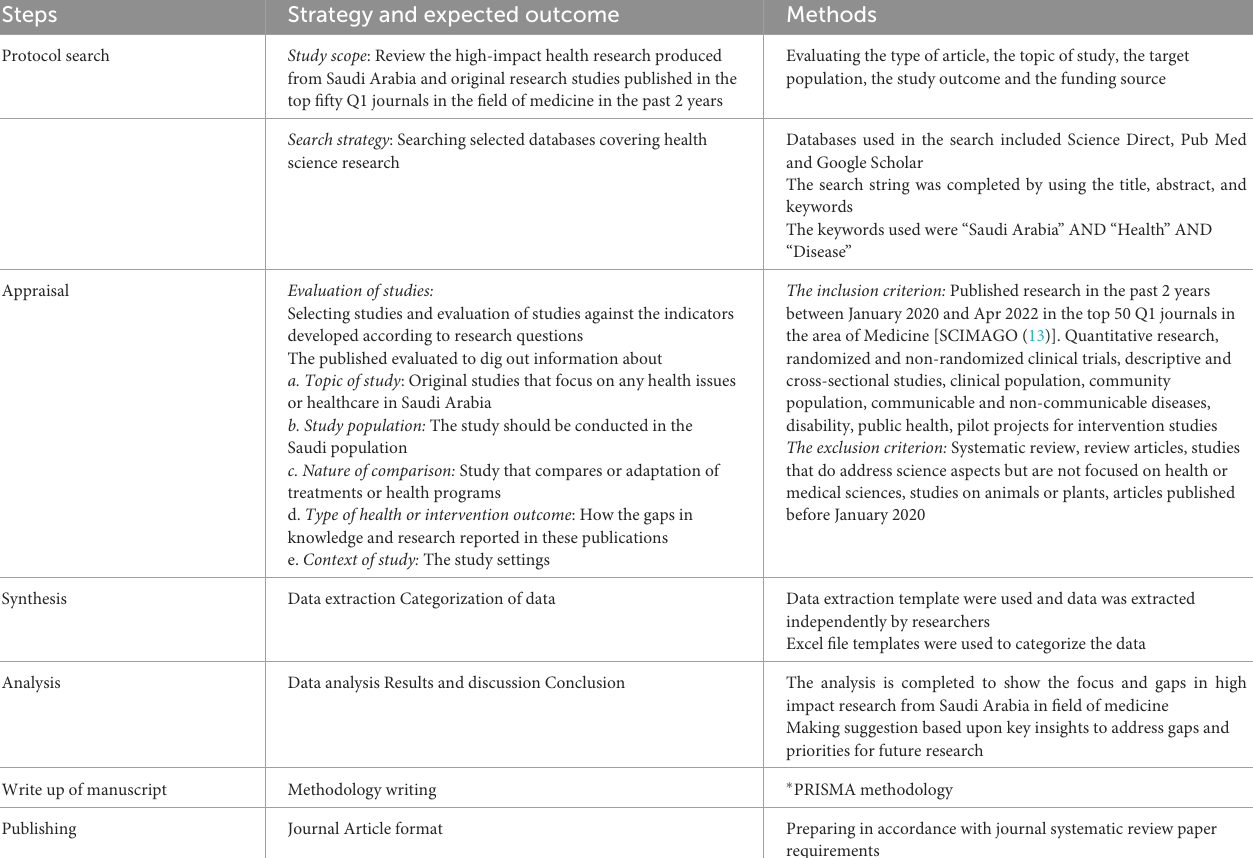
TABLE 1 PSALSAR framework utilized to conduct a systematic review of health research studies in Saudi